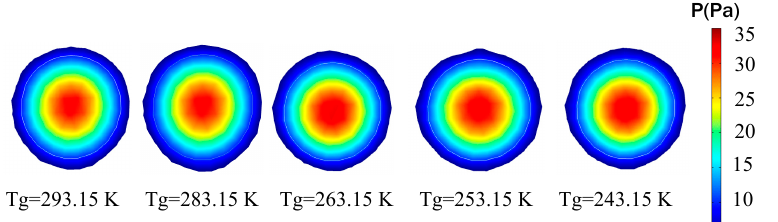
Figure 7. Pressure distribution cloud of the free-falling water droplet at t = 0.02 s. The white circle is the interface of water droplet and air.